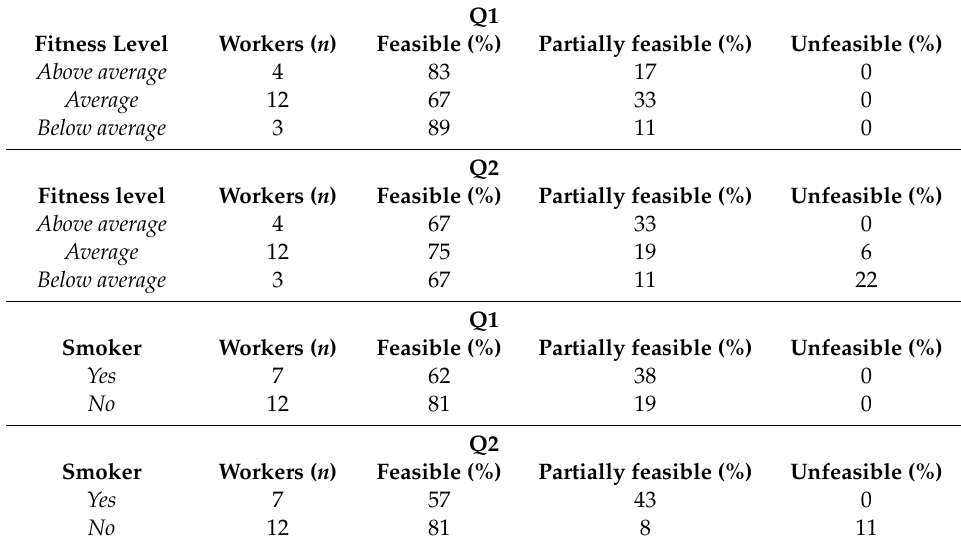
Table A2. Perceived feasibility of the Goldilocks games sorted by fitness level and smoke